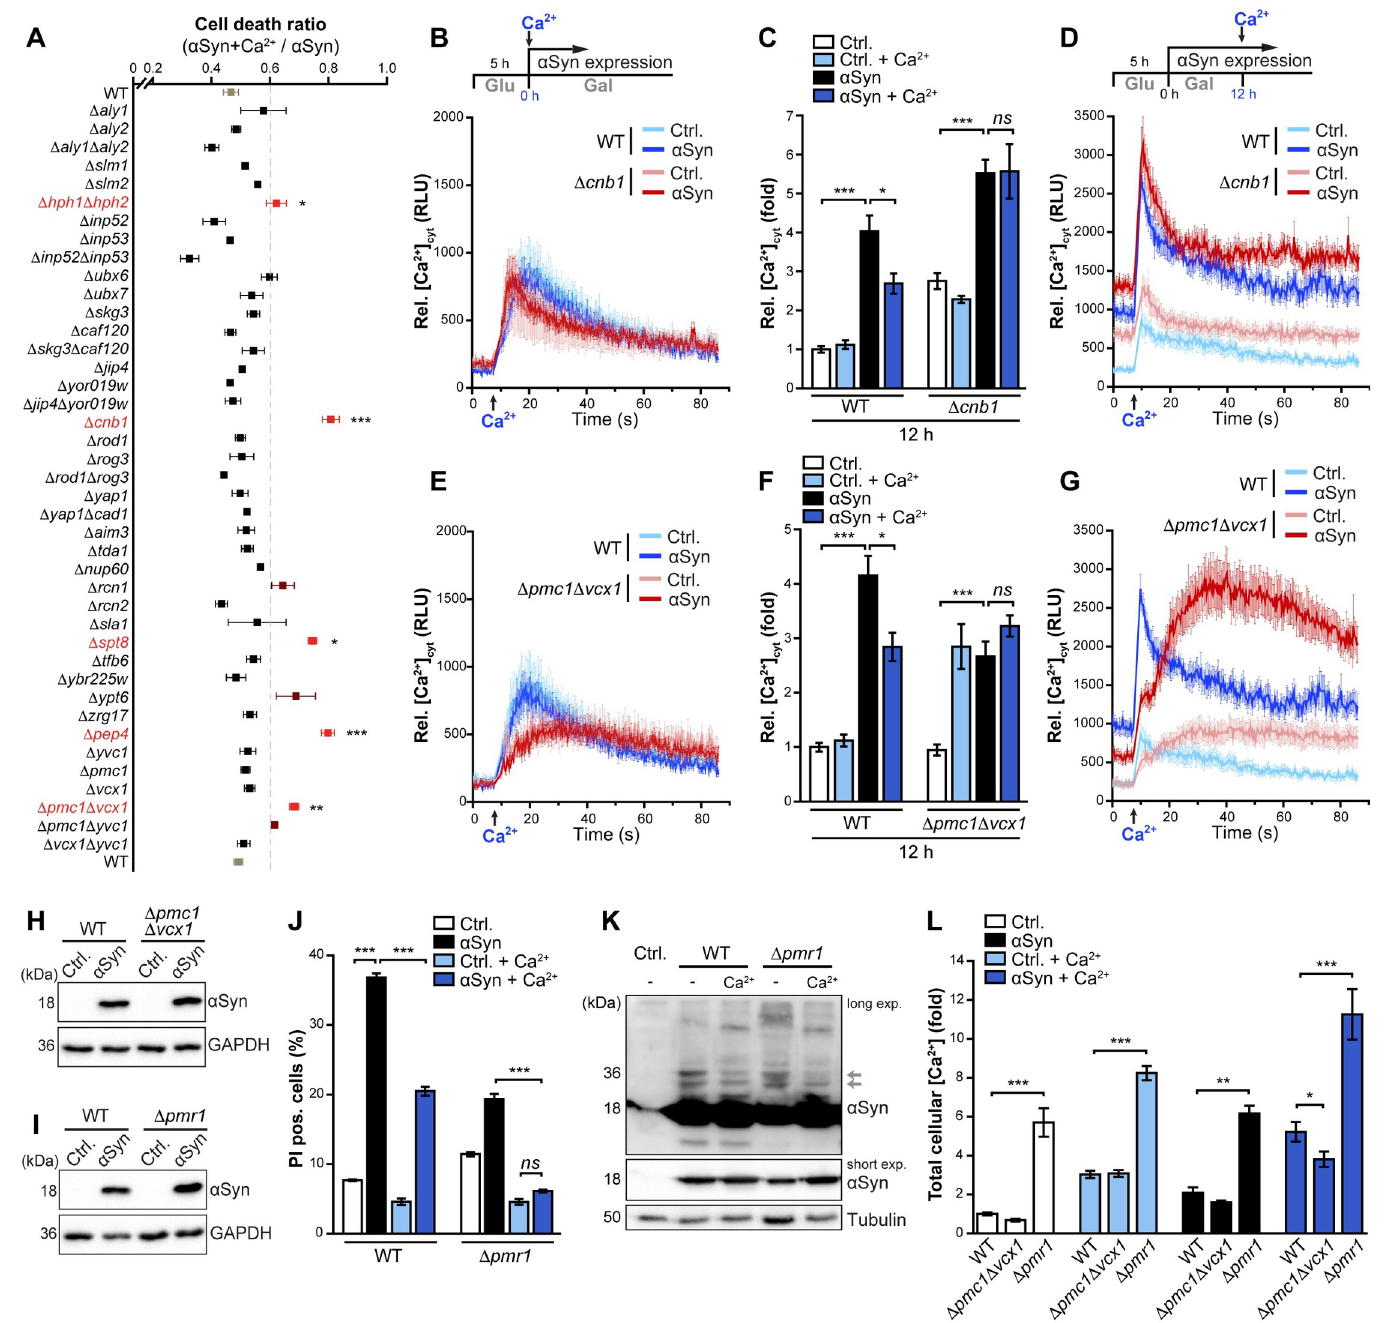
Fig 4. Organellar Ca 2+ -sequestration differentially contributes to Ca 2+ -mediated cytoprotection. ( A ) Cell death determined by propidium iodide (PI) staining of WT cells and indicated deletion mutants, expressing α Syn for 36 h. Untreated cells were compared to cells treated with 10 mM Ca 2+ , and the cell death ratio ( α Syn+Ca 2+ / α Syn) was plotted. Strains above a threshold of 0.6 are depicted in bright red (if different to WT ratio with p < 0.05) or in dark red (if not significant). Means ± s.e.m; n = 4–8. ( B-G ) Measurement of basal cytosolic Ca 2+ levels in WT cells and Δ cnb1 mutants (B-D) or Δ pmc1 Δ vcx1 mutants (E-G) equipped with the aequorin reporter plasmid and expressing α Syn or harboring the vector control (Ctrl.). Rapid transient [Ca 2+ ] cyt responses within 80 s upon early (B, E) or late (D, G) addition of 10 mM Ca 2+ to cells expressing α Syn for 0 h (B, E) or 12 h (D, G) were quantified. In addition, resting cytosolic Ca 2+ levels (C, F) were determined 12 h after cells expressing α Syn have been treated with 10 mM Ca 2+ . Means ± s.e.m; n = 6–8. ( H, I ) Immunoblot analysis of protein extracts from WT, Δ pmc1 Δ vcx1 and Δ pmr1 cells expressing α Syn for 24 h or harboring the vector control. Blots were probed with antibodies directed against FLAG-tagged α Syn and against glyceraldehyde 3-phosphate dehydrogenase (GAPDH) as a loading control. ( J ) Cell death determined by PI staining of WT and Δ pmr1 cells expressing α Syn for 36 h or harboring the vector control. Cells were grown for 36 h in galactose media with or without the addition of 10 mM Ca 2+ at the time point of shift to galactose media. Means ± s.e.m; n = 4. ( K ) Representative semi-native